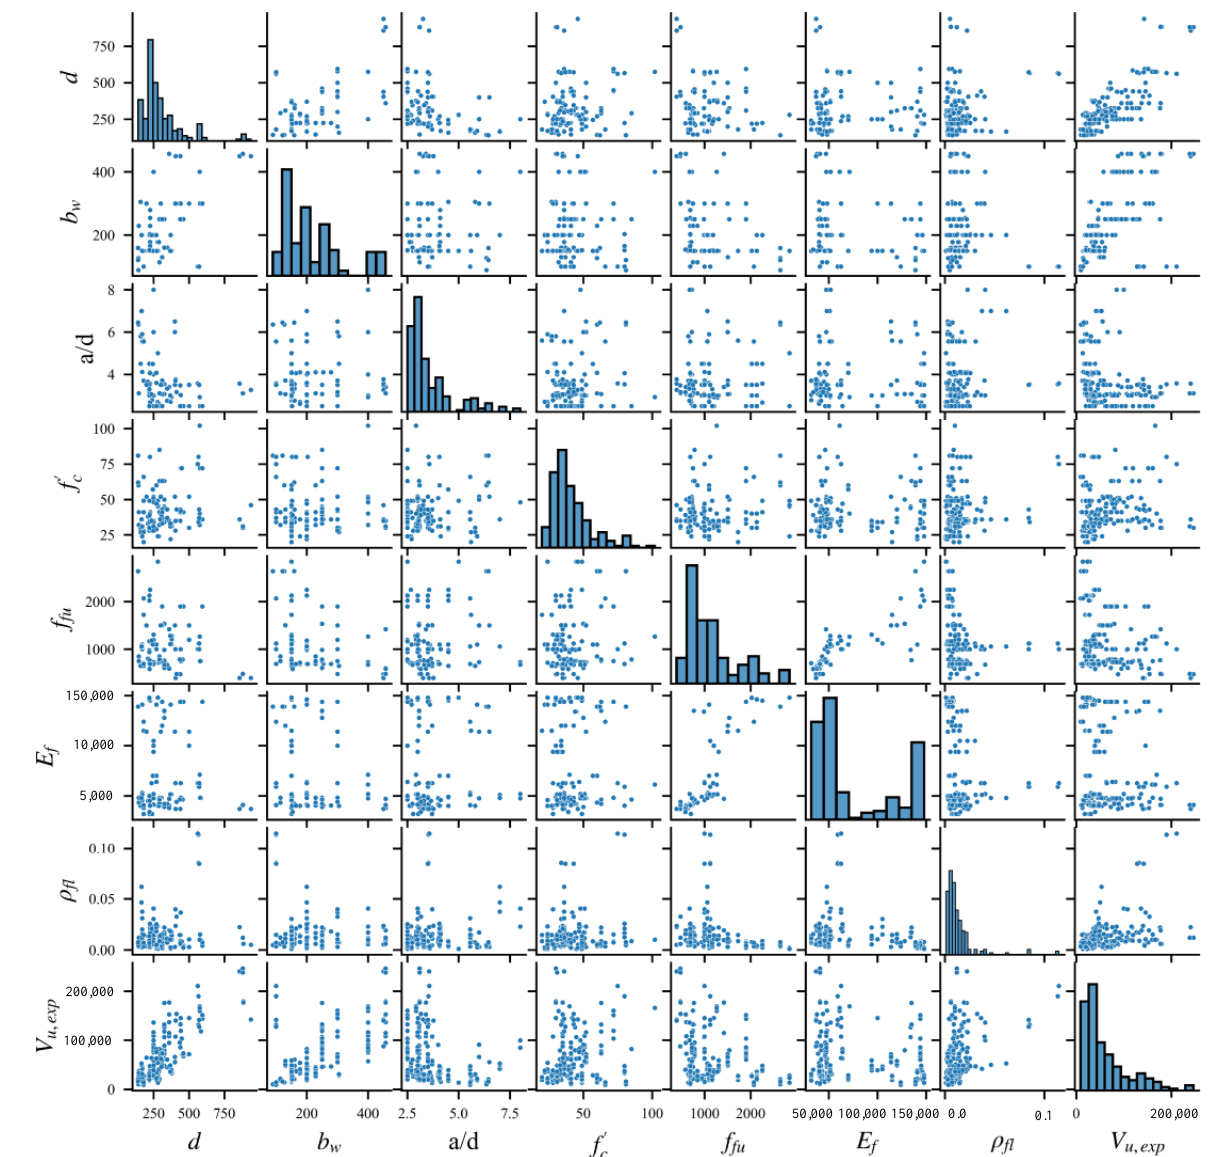
Figure 2. Distributions and correlations between the input